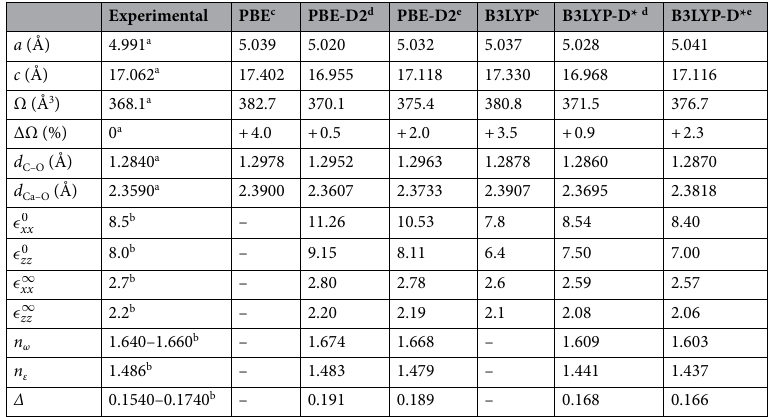
Table 1. Calculated structure (unit cell parameters a and c , volume Ω, C–O bond distance d C–O and Ca–O 0 interaction distance d Ca–O ), dielectric tensor components (static ǫ and high-frequency ǫ ∞ ), refractive index (ordinary n ω and extraordinary n ε ) and birefringence ( δ ) of calcite, obtained at DFT level with PBE-D2 and B3LYP-D* functionals corrected for long-range interactions in static condition (0 K) and at 298 K